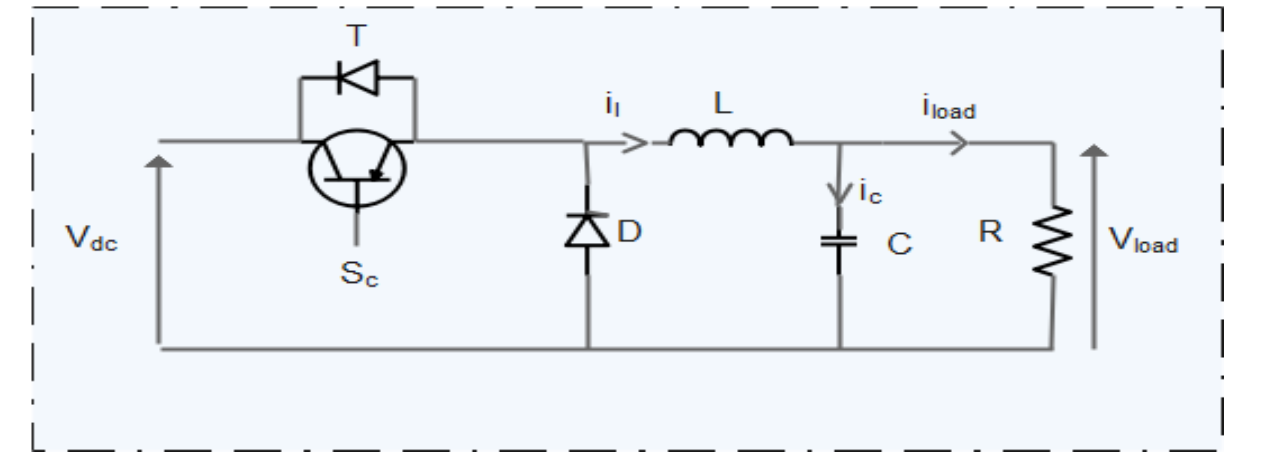
Figure 1. Synoptic scheme of the DC-DC buck converter.